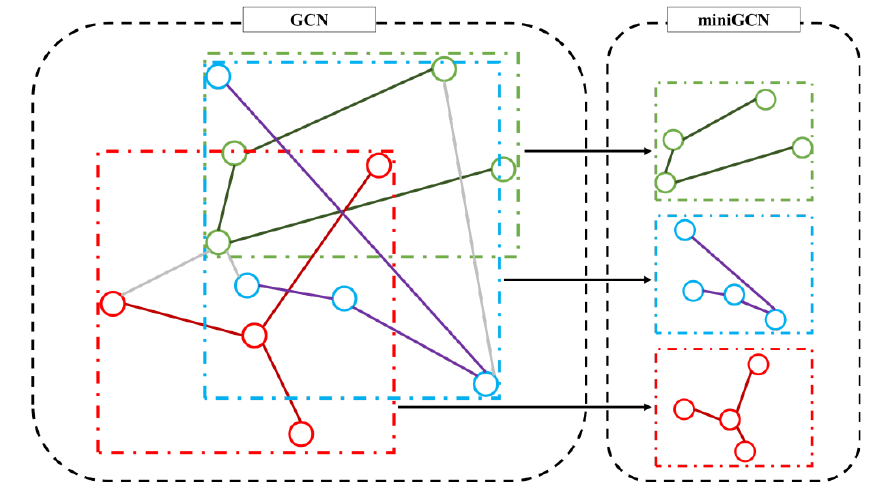
Figure 3. Batchwise structure of miniGCN. Three minibatches are considered with the random node sampler size of M = 4, compared to full graph with N = 12 nodes.